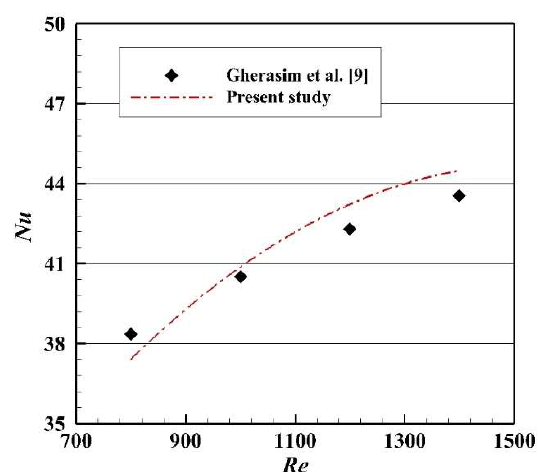
Figure 5. Comparison of the predicted averaged Nusselt number with the literature [9].